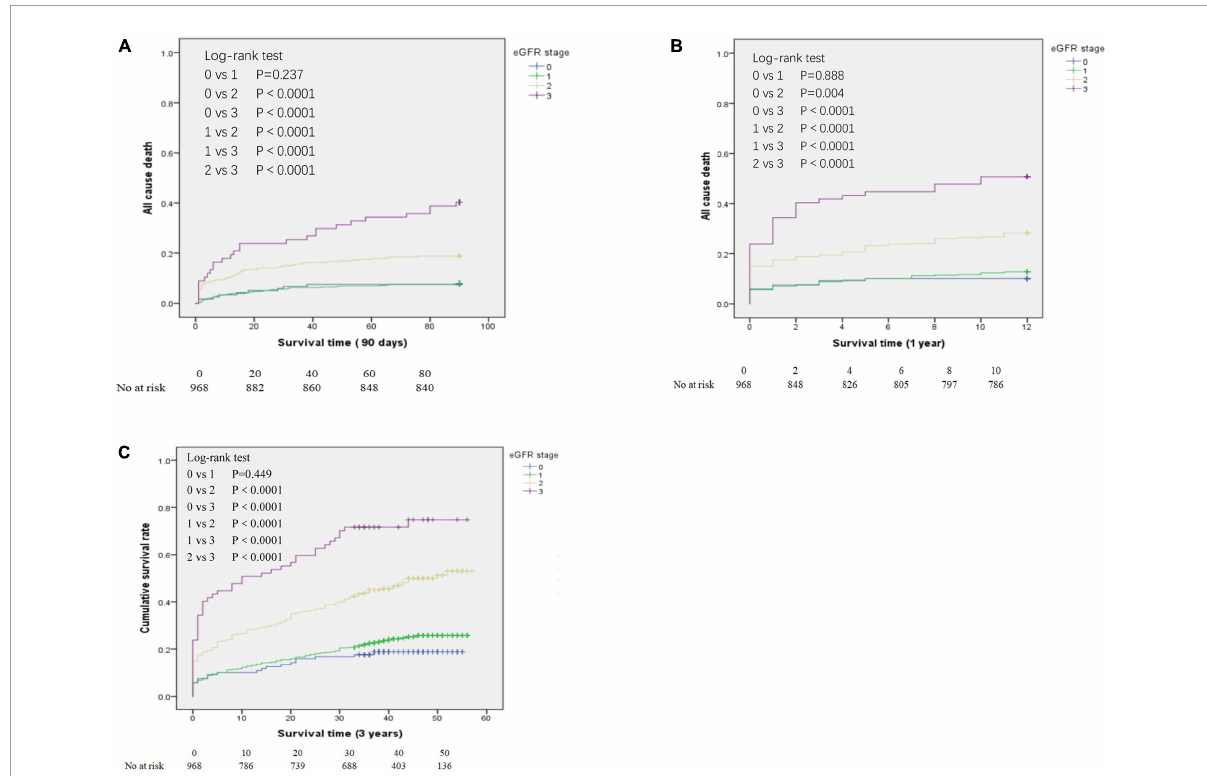
FIGURE2 Kaplan-Meier analysis of all-cause mortality for patients in the different estimated glomerular filtration rate (eGFR) groups who survived at least 90 days (A) , at least 1 year (B) , and at least 3 years (C) . eGFR groups are defined in Table 1 .